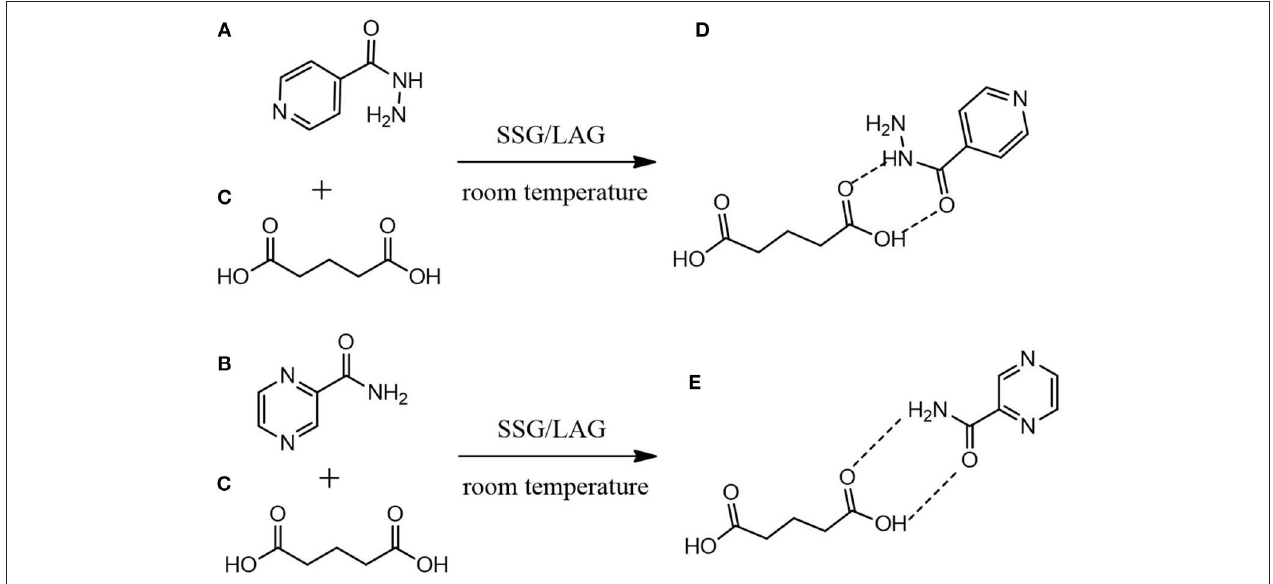
FIGURE 1 | Proposed molecular mechanistic for the formation of (D) INHGA (2:1) and (E) PGA (2:1) co-crystals of (A) isoniazid and (B) pyrazinamide with (C) glutaric acid as a co-former using solid-state grinding (SSG) and liquid-assisted grinding (LAG).